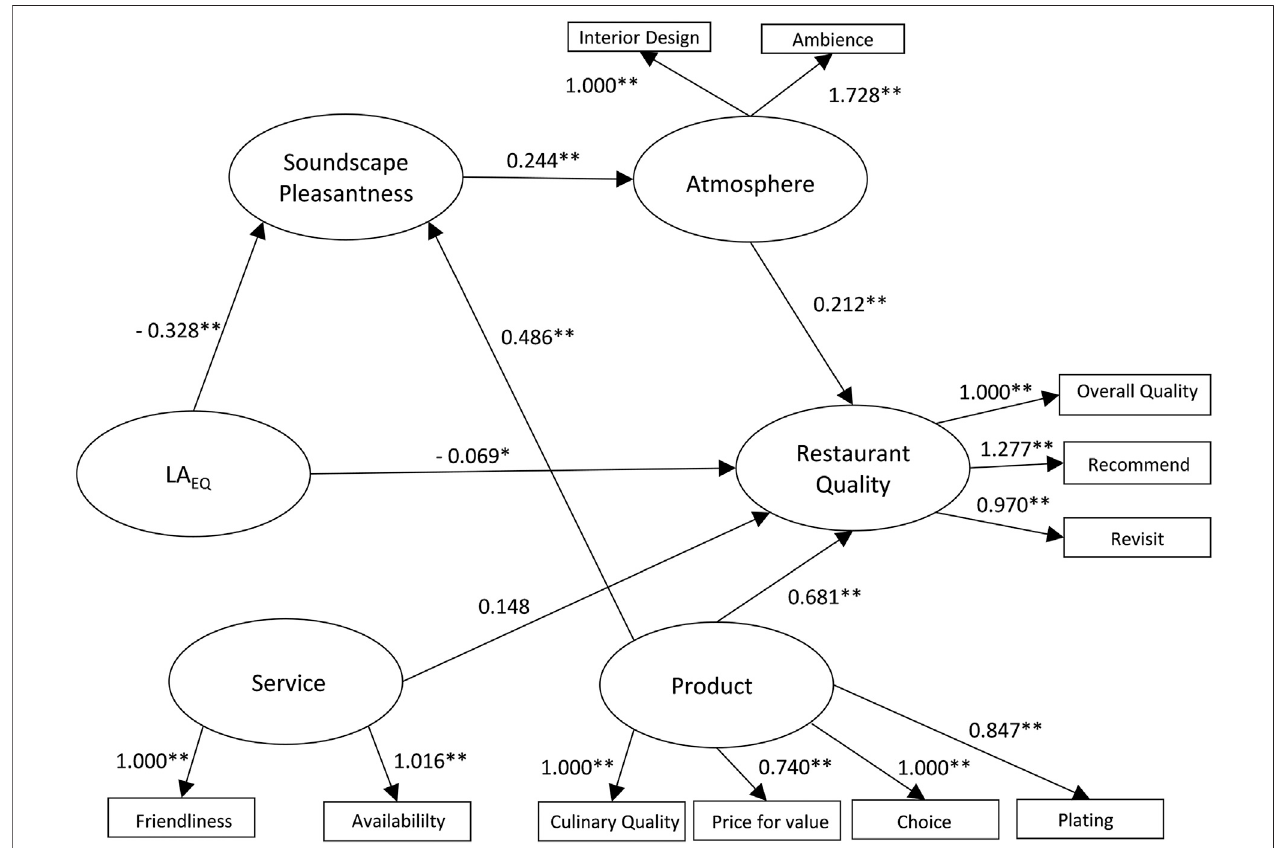
FIGURE 7 | Structural equation model predicting restaurant quality, including acoustical and non-acoustical factors. Note: The estimates represent standardized regressioncoef fi cients β ,andtheasterisksindicatethesigni fi canceoftherespectiveeffects,* p < 0.05,** p < 0.01,asobtainedbytheSEMroutineoftheLavaanPackage in